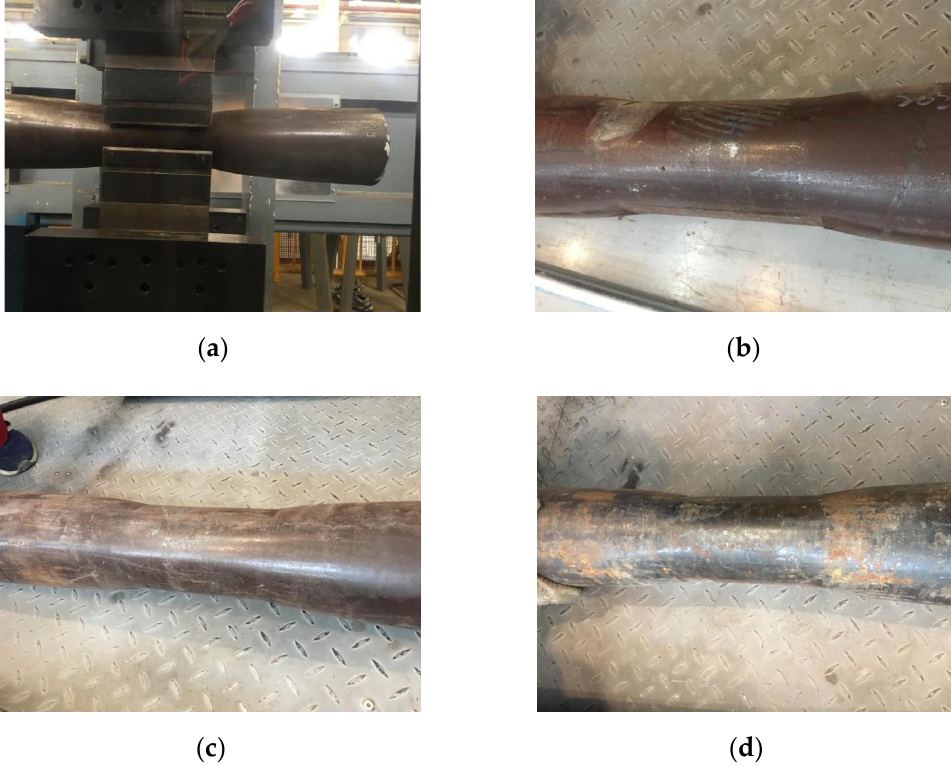
Figure 10. Casing morphology after external extrusion test: ( a ) extrusion test process; ( b ) #1 casing appearance after extrusion test; ( c ) #2 casing appearance; ( d ) 125 ksi casing appearance.